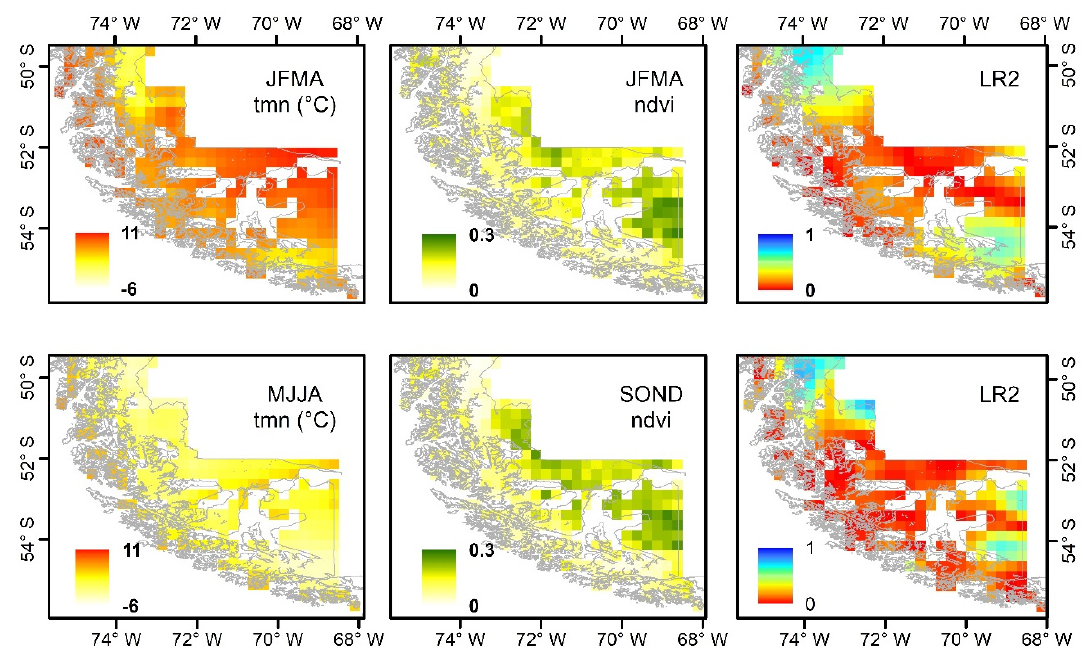
Figure 4. Spatial patterns of mean minimum temperature (left-hand plots), NDVI (center plots) and explained variance of the regression between mean minimum temperature and NDVI values from 1985–2018 (right-hand plots). JFMA = January to April, MJJA = May to August, SOND = September to December, LR2 = local squared regression coefficient.